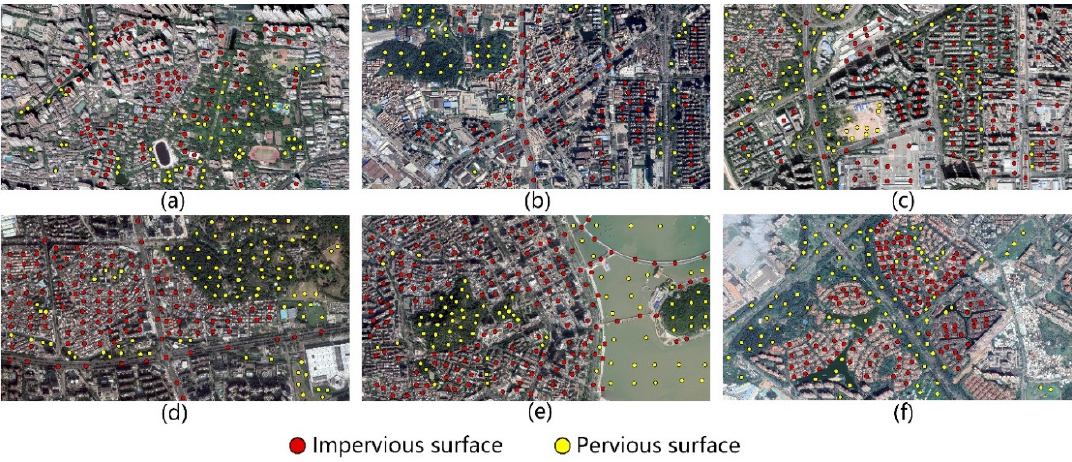
Figure 3. Historical images and verification samples in 2016; ( a ) Guangzhou; ( b ) Foshan; ( c ) Shenzhen; ( d ) Zhongshan; ( e ) Zhuhai, and ( f ) Dongguan.